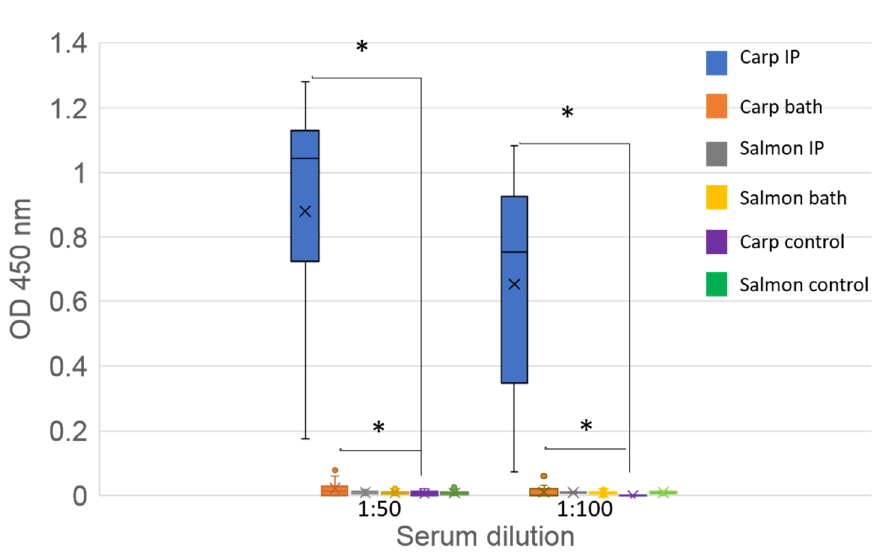
Figure 7. ELISA detection of CSBV antibodies in serum from challenged common carp and Atlantic salmon. Sera tested at 1:50 and 1:100 dilutions. Each bar represents from each group the median (cross), upper and lower quartile (box) and upper and lower extreme (line) of the optical density (OD) at 450 nm. Single points indicate outliers. Sample number per group: 15. IP: intraperitoneally injected fish; bath: bath infected fish. Asterisks (*) denotes significant di ff erences ( p < 0.5) between the treated and control groups.